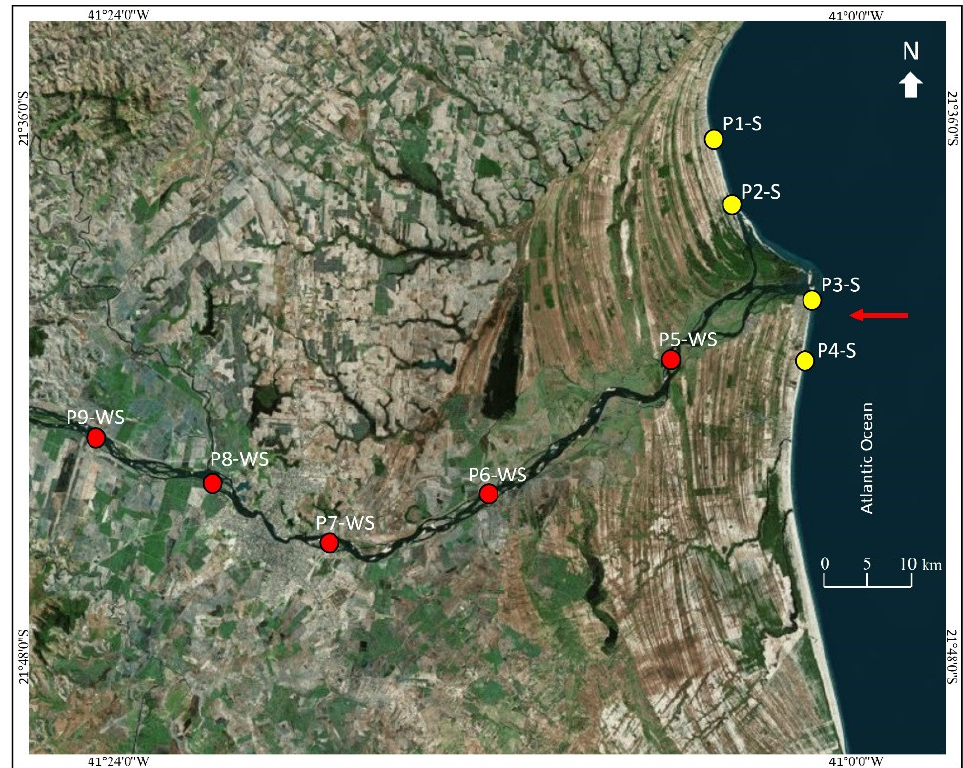
Figure 2. The sampling sites along the river (red circle) and littoral (yellow circle). The coastal erosion zone is indicated by the red arrow, and the extended area is represented in Figure 1. The geographic coordinate system is UTM Sirgas 2000.